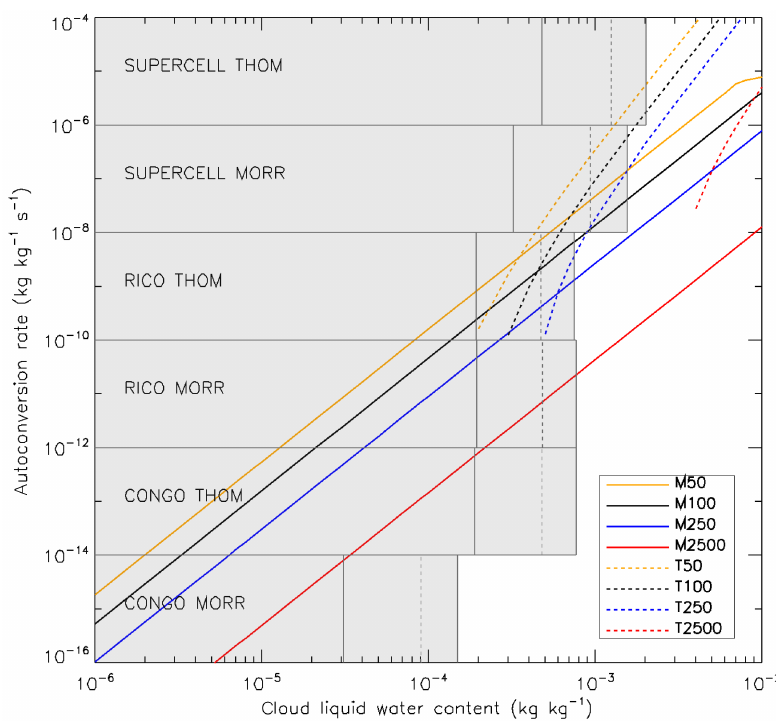
Figure 14. Autoconversion rate as a function of cloud water content for the MORR and THOM microphysics schemes (solid and dashed lines, respectively) for super pristine, pristine, moderately polluted and polluted conditions. Also shown are labelled grey bars showing the mean (solid vertical grey line) and 1 and 2 standard deviations (dashed vertical grey line and end of bar, respectively) for cloud water content averaged over all prescribed CDNC configurations for each case (note that the variability in mean cloud water content with CDNC is significantly less than the variability due to microphysics scheme).